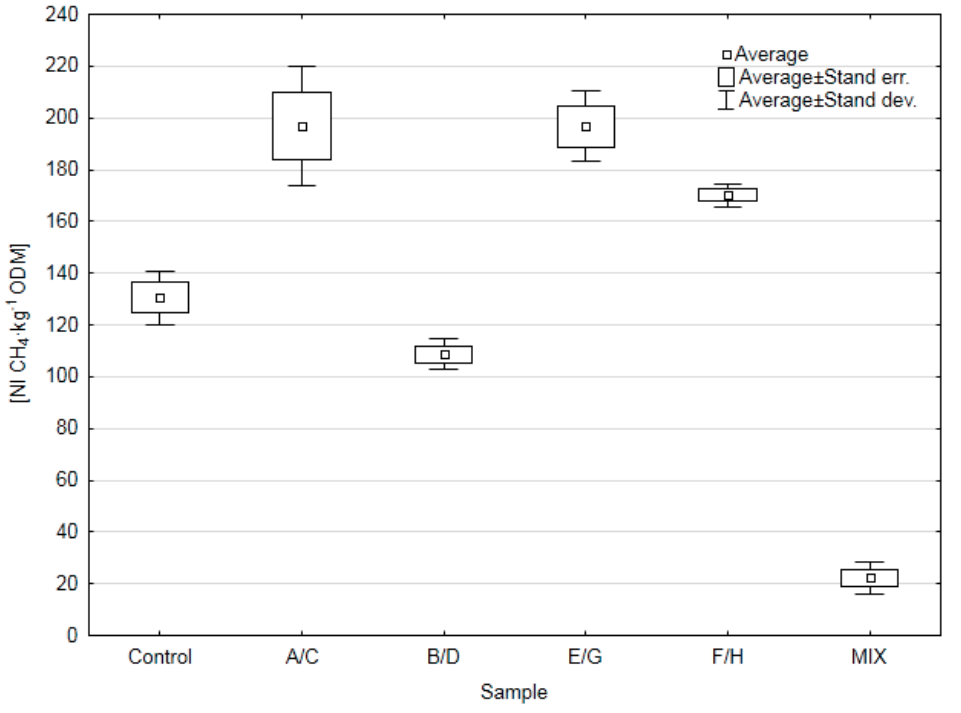
Figure 6. Average yields of methane in the tested samples.